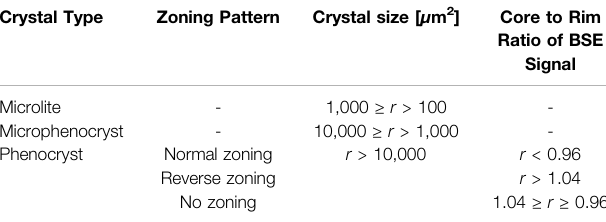
TABLE 2 | Assignment rules for the automated classi fi cation of olivine